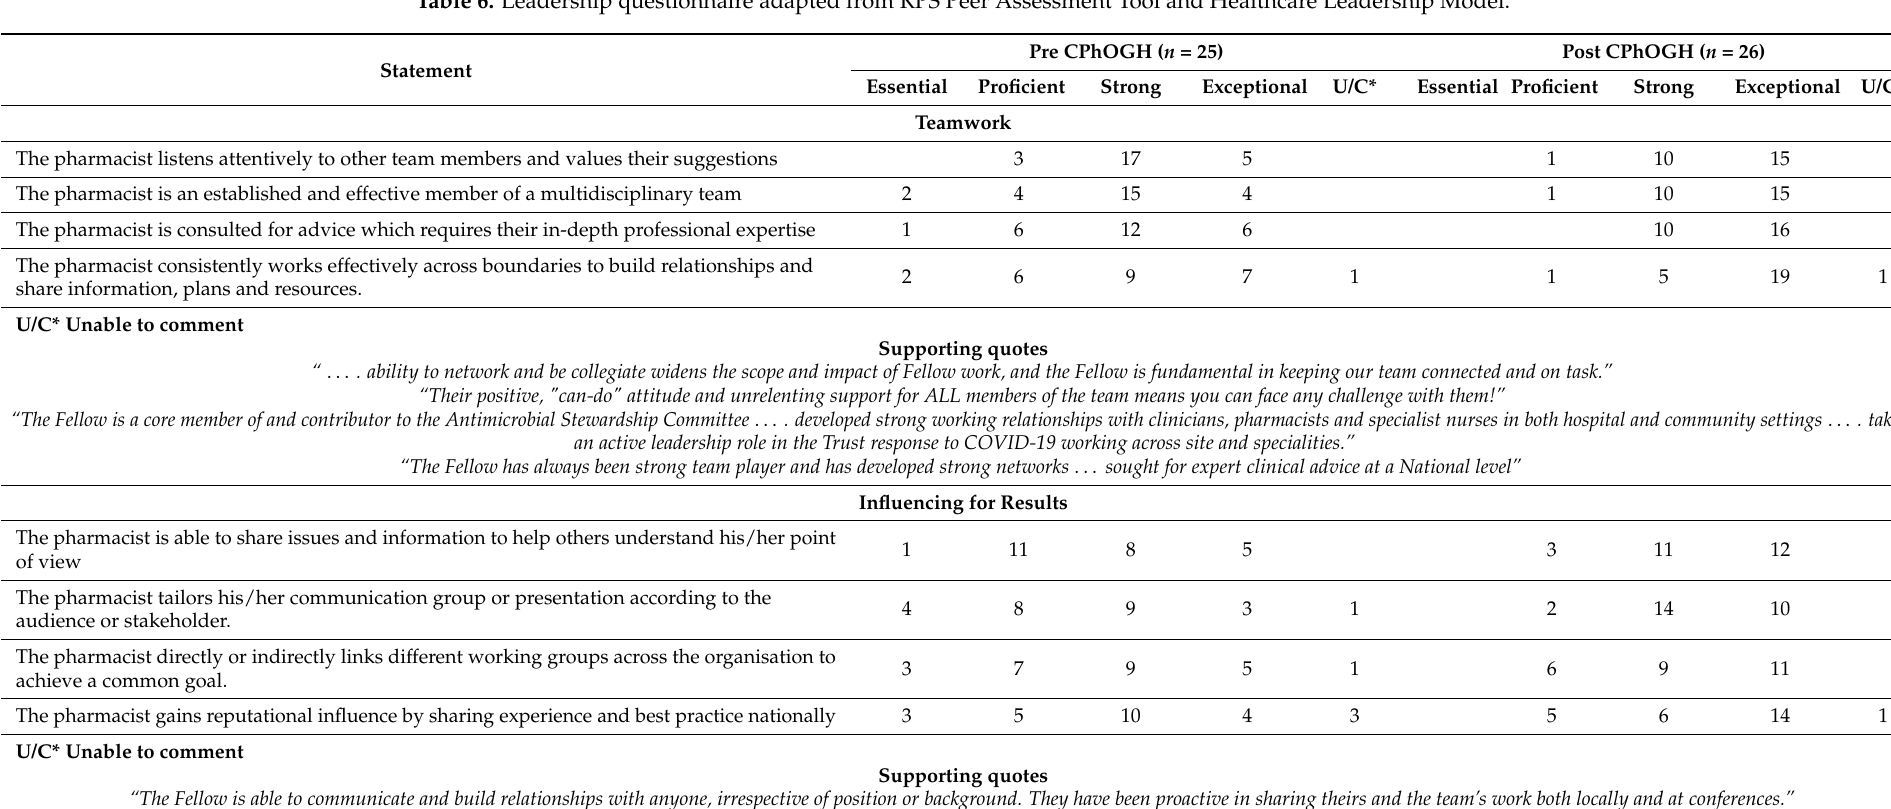
Table 6. Leadership questionnaire adapted from RPS Peer Assessment Tool and Healthcare Leadership